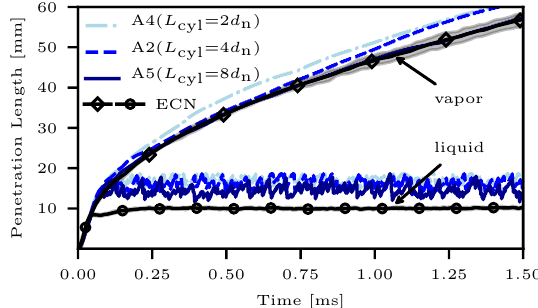
Figure 6. Liquid and vapor penetration for cases with varied L cyl and constant D cyl = 5 d n , compared with Engine Combustion Network (ECN) data. Filled region denotes ECN experimental uncertainty within an ensemble-average.